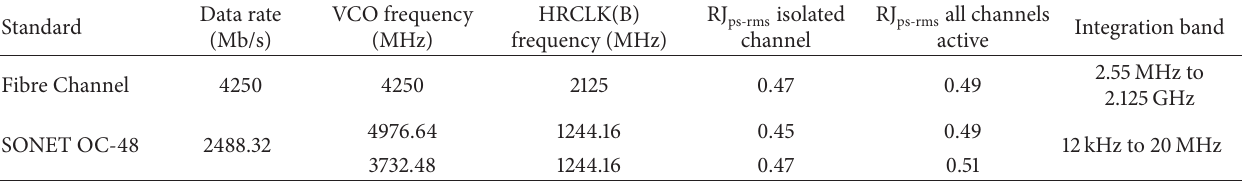
Table 2: Summary of the CSU clock jitter for selected wireline standards.